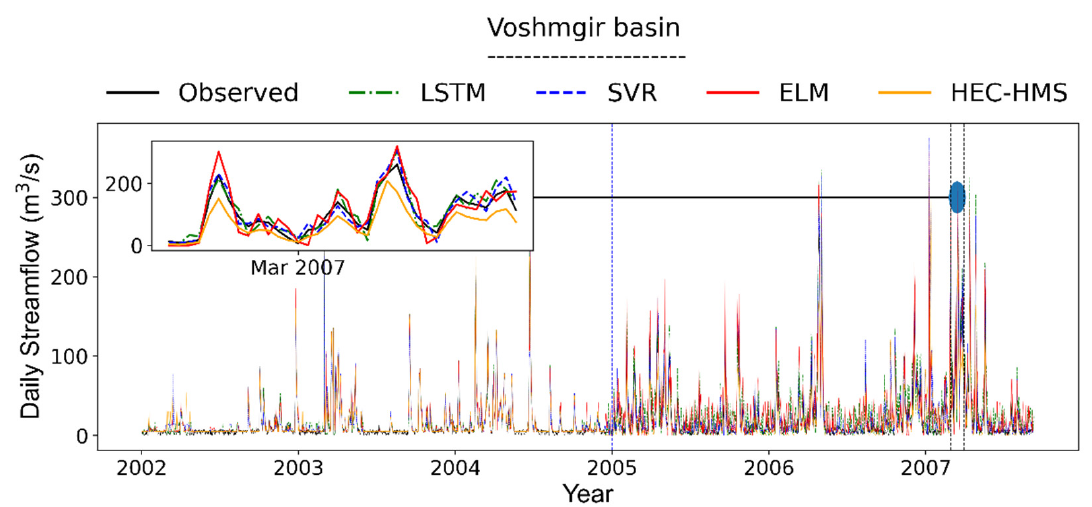
Figure 5. Comparison results between observed and simulated daily streamflow during the calibra- tion and validation periods for ML models. The blue vertical dashed line divides the time series into calibration and validation periods. A zoom-in of the blue circle area investigates the model’s performance in March 2007.